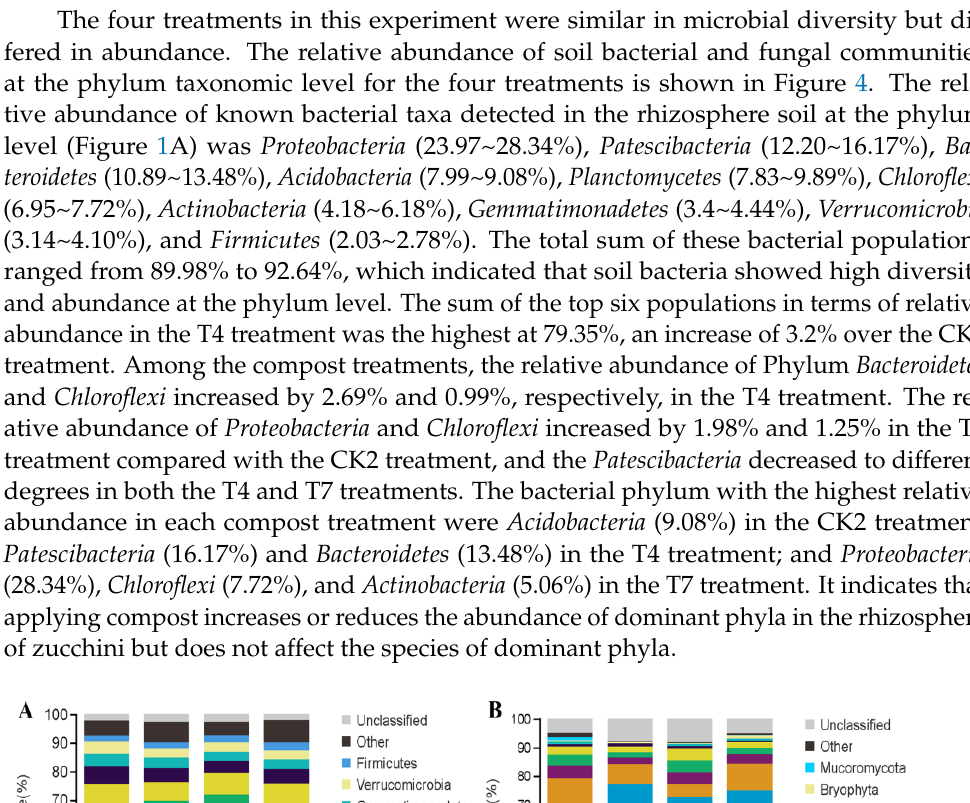
Figure 3. Principal coordinate analysis (PCoA) plots of bacterial ( A ) and fungal ( B ) community composition at the OTU level.